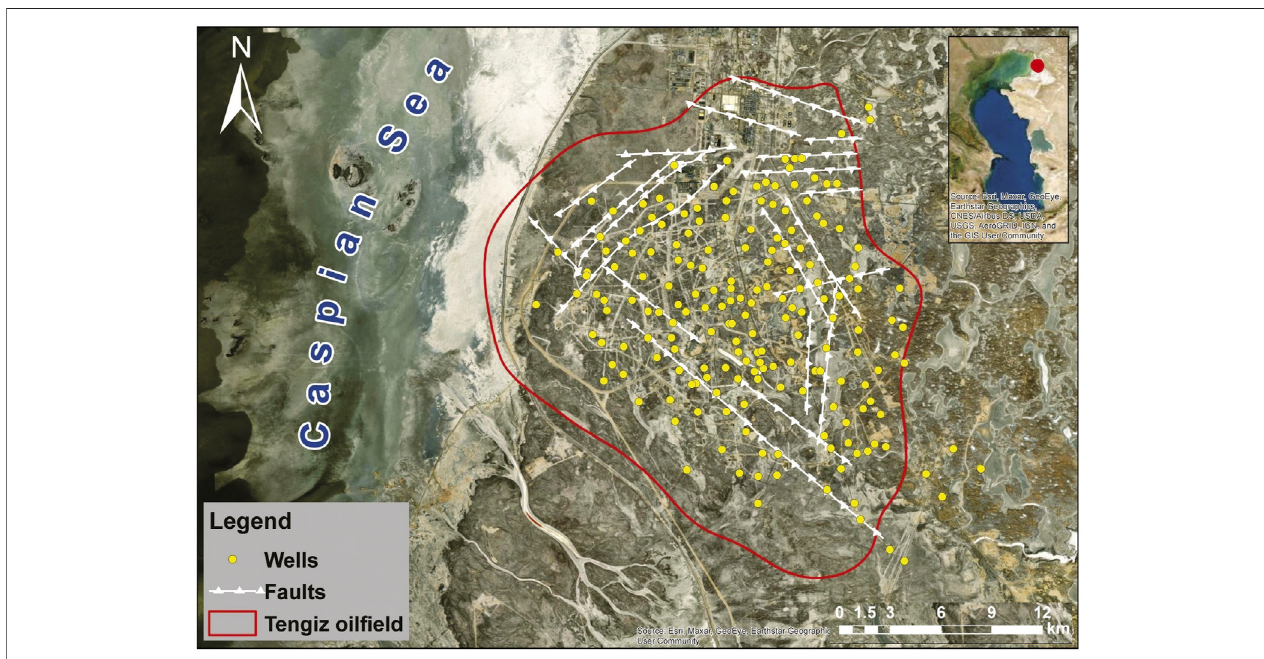
FIGURE 1 | Tengiz oil fi eld with the representation of wells and